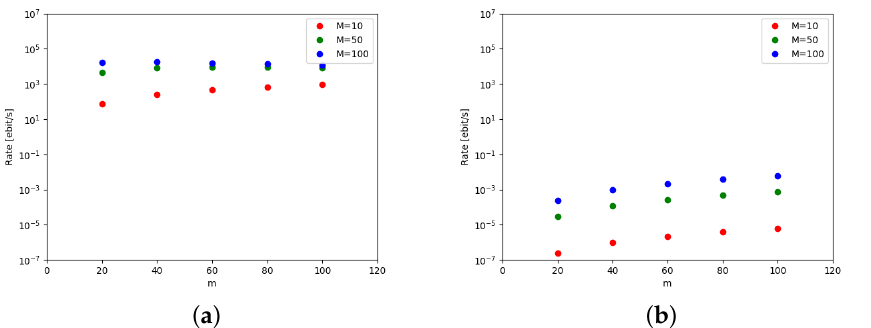
Figure 4. Capacity of a QR chain with simultaneous BSMs, using M parallel channels, and a time- multiplexing block length m . We assume a 3-link QR chain with α 1 = 0.25 dB/km, α 2 = 0.15 dB/km, α 3 = 0.25 dB/km, τ = 50 ns, µ = 0.405, and q = 0.255. In ( a ), the three links have lengths L 1 = 25 km, L 2 = 40 km, and L 3 = 30 km, respectively. In ( b ), the lengths of all the three links are